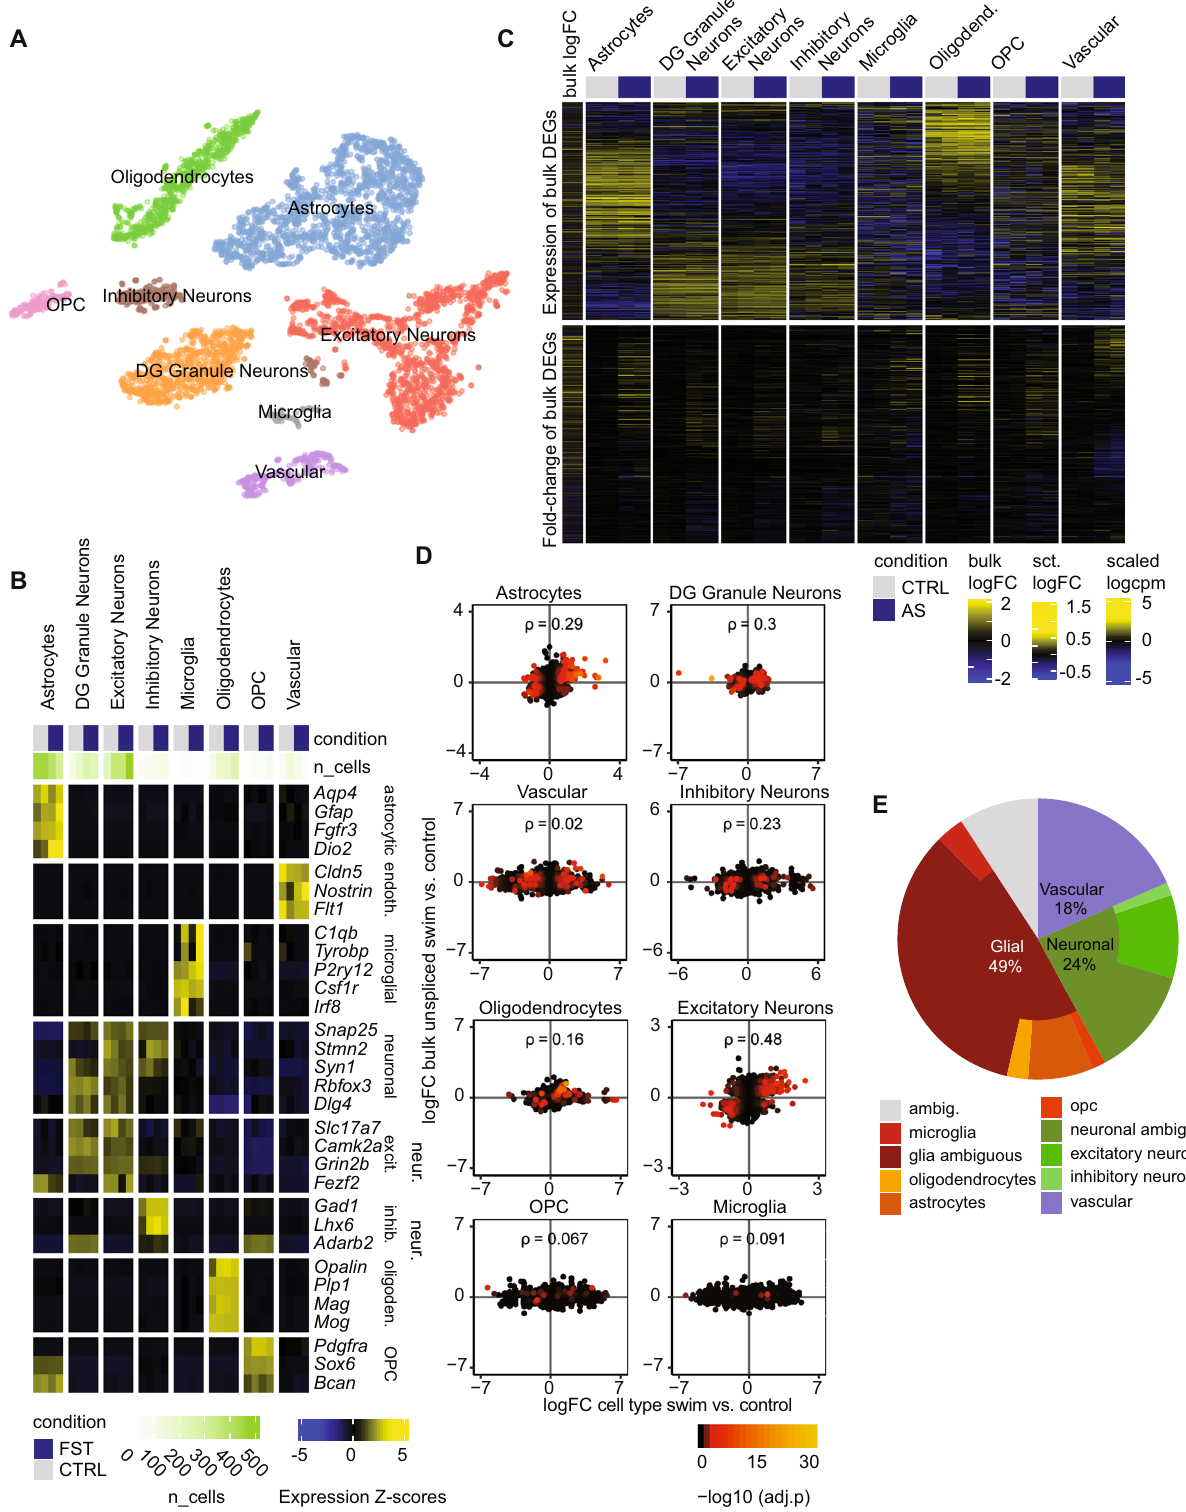
Fig. 4 Single nucleus RNA sequencing 45 minute after acute stress (AS). A t-SNE plot of single-nuclei transcriptomes labeled by cell-type. B Expression of known markers across the fi nal snRNAseq clusters. Cell-level counts were aggregated by sample and cluster and normalized at the pseudo-bulk level. C Top: Heatmap indicating overall expression of stress responsive genes (from bulk sequencing) in logcpm in snRNA cell types. Bottom: Heatmap indicating logFC after AS of these genes in the snRNA data. D Correlations between logFCs of DEGs in bulk sequencing (45 min unprocessed) and logFC of snRNAseq data within cell types ( ρ = Spearman ’ s rank correlation coef fi cient). Color indicates adjusted p value in snRNAseq data. E Decomposition analysis highlights which cell types best explain DEGs from the bulk sequencing in the snRNAseq data. Experiments performed in male